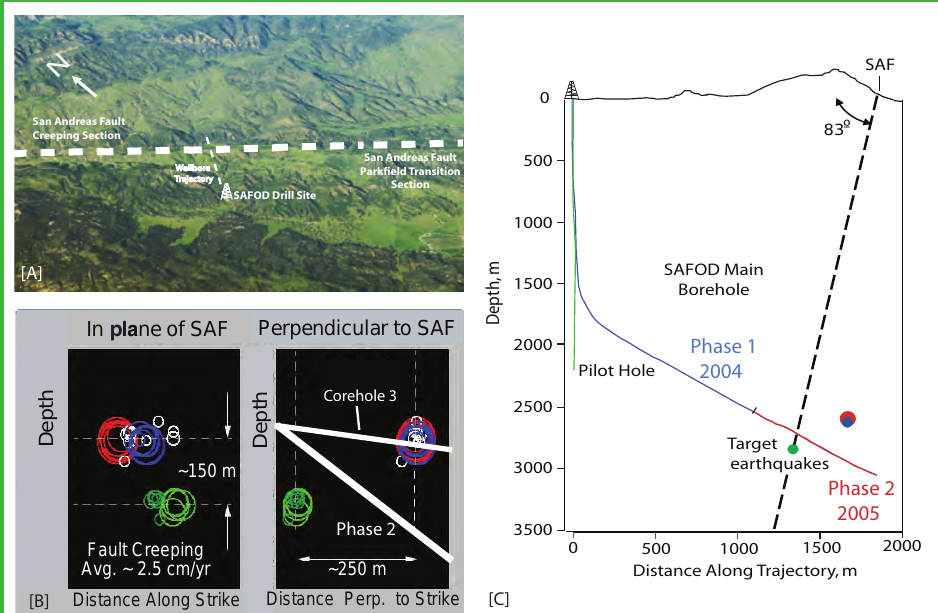
Figure 2. [A] The SAFOD drill site is located at the southeastern end of the creeping section of the fault, where the surface creep rate begins to gradually decrease in the Parkfield section. [B] There are three groups of repeating earthquakes in the target area. As shown in the cross-section in a plane parallel to the fault, the groups of repeaters shown in red, blue, and green correspond to M~2 earthquakes that recur every ~2.5 years. As shown in the cross-section perpendicular to the fault, the red and blue repeaters occur on a different strand of the fault than the green repeaters. Hence, there are multiple active fault traces at depth. The white lines schematically illustrate the location of the SAFOD main borehole—drilled in the summers of 2004 and 2005—and a core hole targeting the microearthquakes to be drilled in 2007. [C] Trajectories of the SAFOD pilot hole and main hole. The microearthquake locations are to the southwest of the surface trace of the